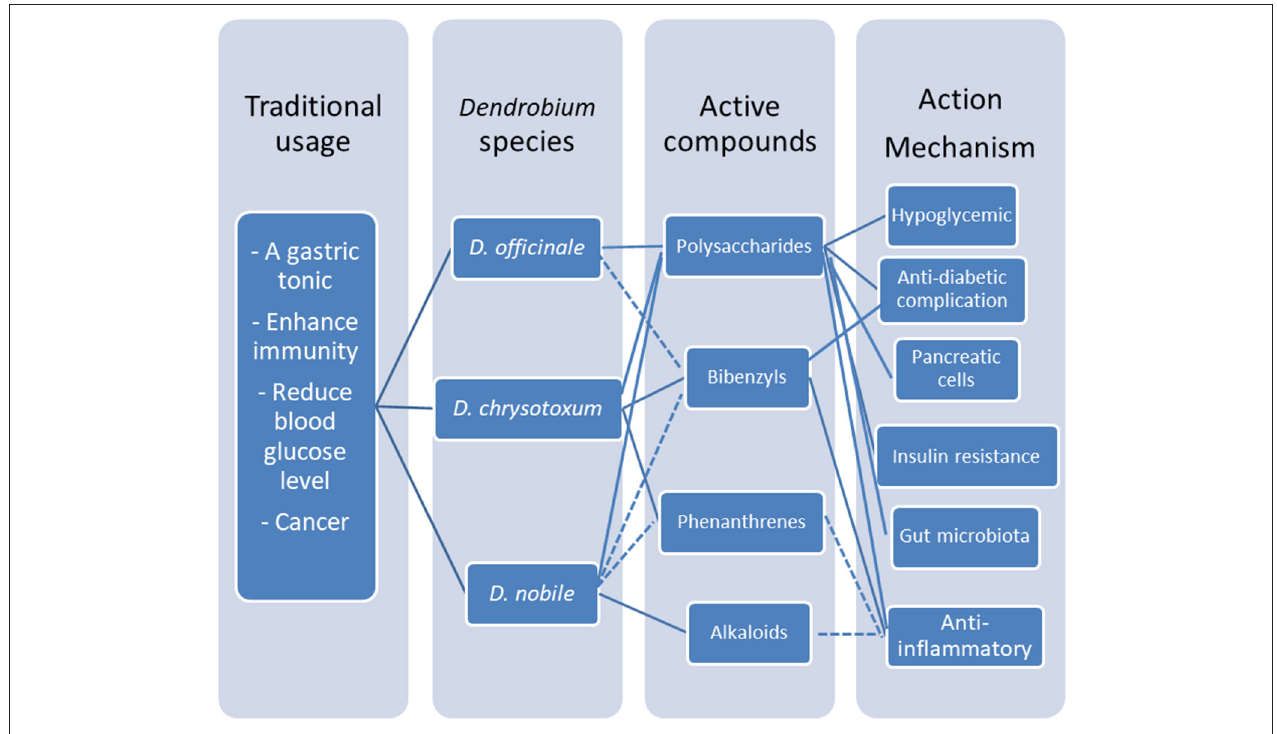
FIGURE 4 | Multiple active compounds and multitargets platform of medicinal Dendrobium . Polysaccharides and bibenzyls are the major active compounds in medicinal dendrobiums for diabetic management, through multiple mechanisms including lowering glucose level and reversing chronic inflammation of T2DM by modulating pancreatic β -cell dysfunction and insulin resistance in liver, and indirectly via gut